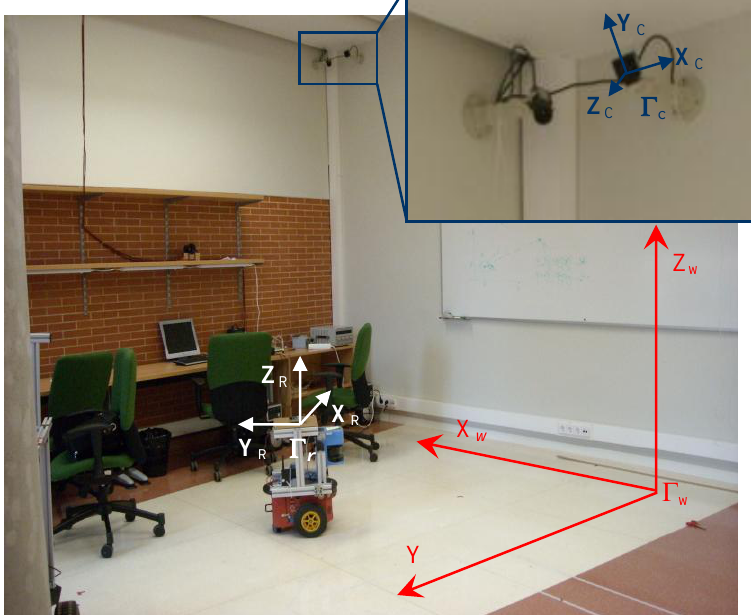
Figure 2. Reference systems in the intelligent space (ISPACE-UAH): World